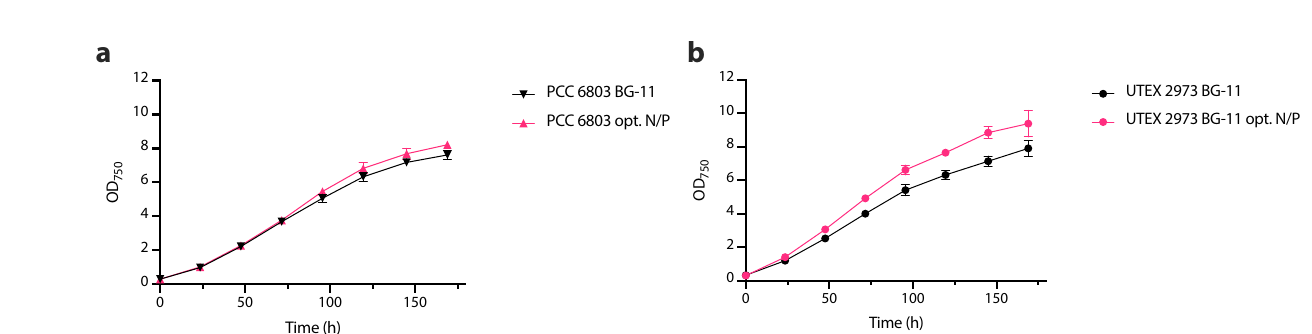
Figure 6. 2D screening of nitrogen and phosphorus source in cyanobacterial cultivation using standard growth media. (a) PCC6803 normalized autofluorescence after 7 days in response to varying concentrations of NaNO 3 and K 2 HPO 4 in BG-11 medium. (b) UTEX 2973 normalized autofluorescence after 7 days in response to varying concentrations of NaNO 3 and K 2 HPO 4 in BG-11 medium. (c) UTEX 3154 normalized autofluorescence after 7 days in response to varying concentrations of NaNO 3 and KH 2 PO 4 in AD7 medium. Data points are averages of approximately 5 ± 3 droplets.